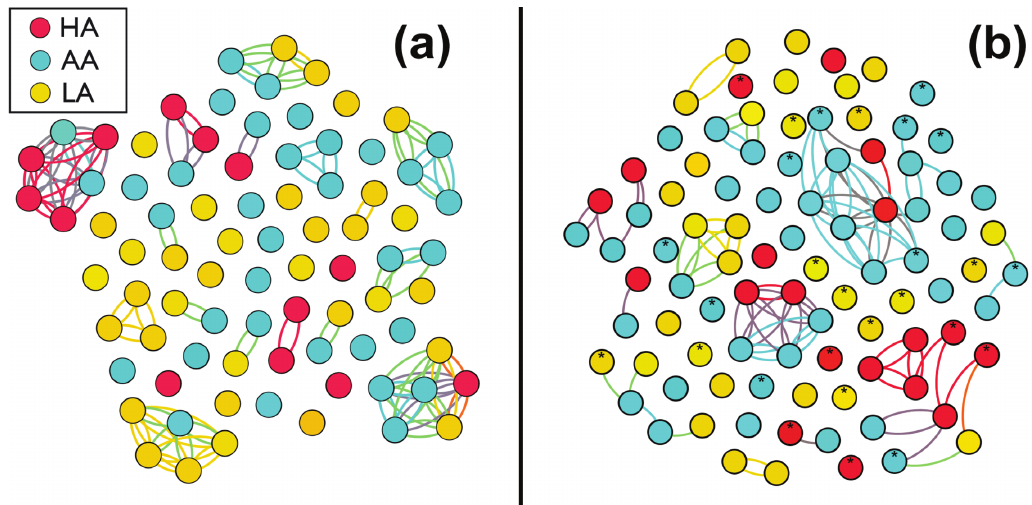
Fig 4. Peer interaction of different groups of students in both contexts. (a) Network scheme from classroom observations in face- to-face context where the links are reciprocal interactions. (b) Network scheme from data obtained through surveys in virtual context. The links can be or not be reciprocal interactions. The nodes marked with an asterisk represent students who claimed to interact with students from another section who did not participate in this study.